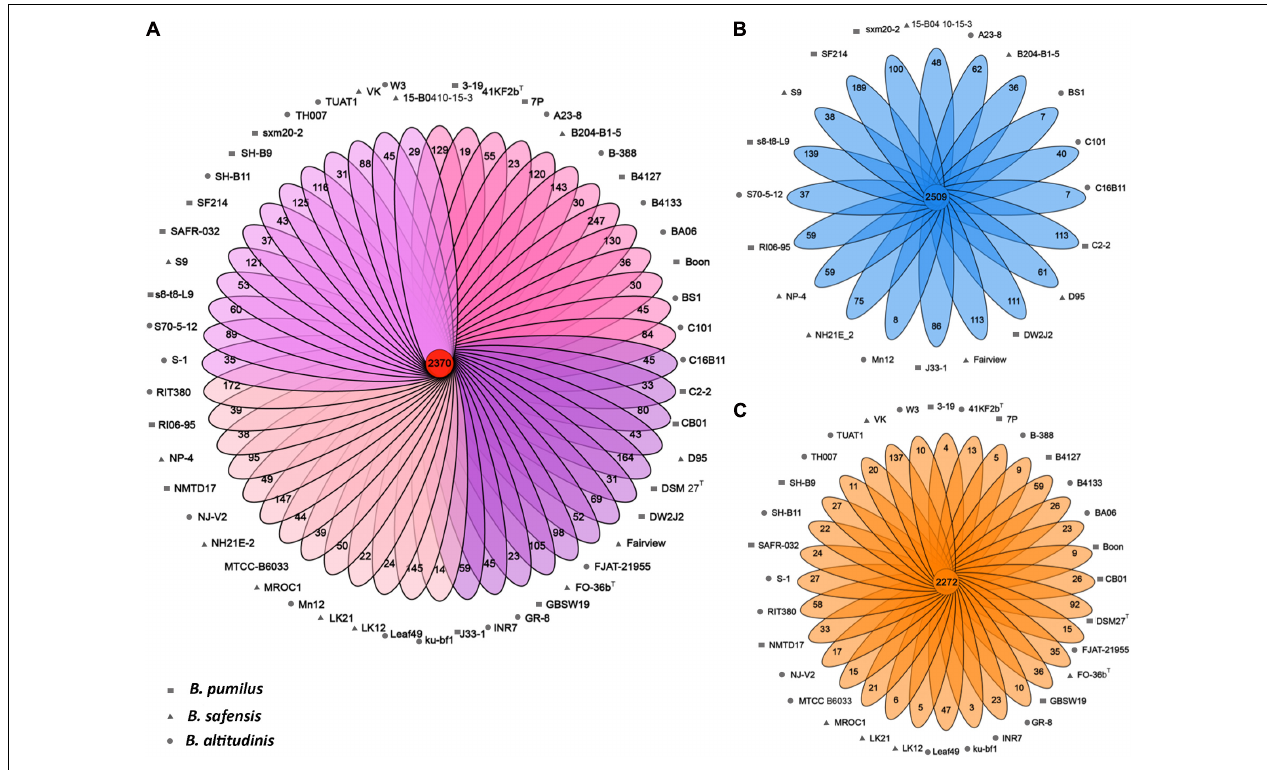
FIGURE 3 | The pan-genomes of Bp group strains. (A) Flower plots showing the core gene number (in the center) and the strain-specific gene numbers (in the petals) in the 52 strains. (B) Flower plots showing the core gene number (in the center) and strain-specific gene number (in the petals) in the marine-isolated subgroups. (C) Flower plots showing the core gene number (in the center) and strain-specific gene number (in the petals) in the land-isolated